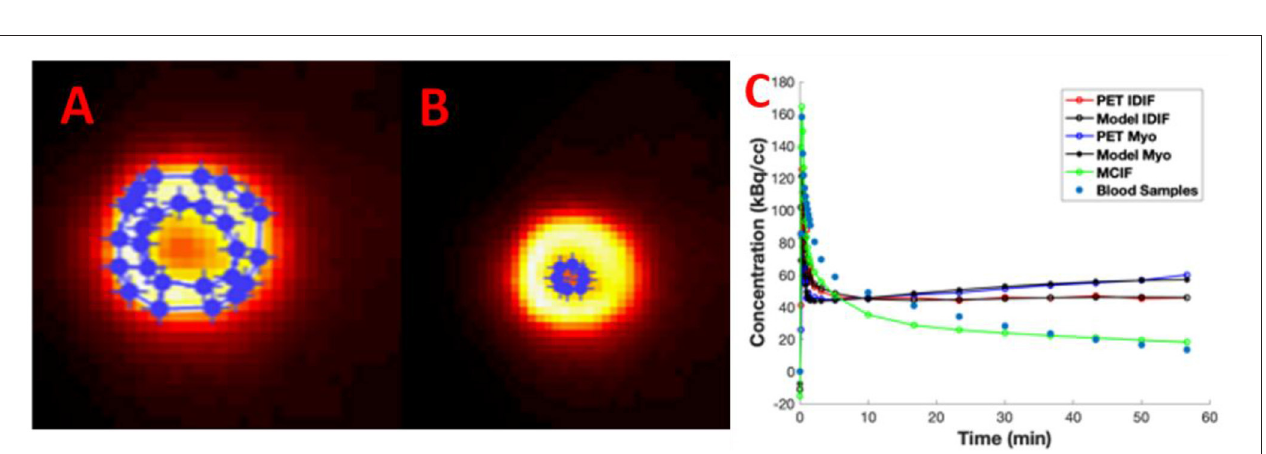
FIGURE 4 | Model-corrected blood input function (MCIF). (A) Representative 2-[18F] fluoro-2-deoxy-D-glucose positron emission tomography (FDG PET) images with regions of interest drawn in the myocardium and (B) left ventricular blood in the last time frame. (C) Dual-output model (Model IDIF, Model Myo) fitted to image-derived blood (PET IDIF) and myocardium (PET Myo) time activity curves (TACs) to generate the MCIF. For comparison, blood samples derived from arterial blood sampling are shown.